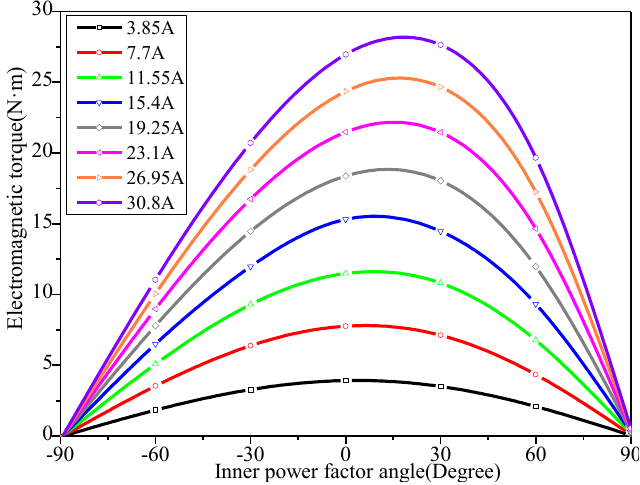
Figure 2. Electromagnetic torques of the FSPM machine with different current amplitudes and inner power factor